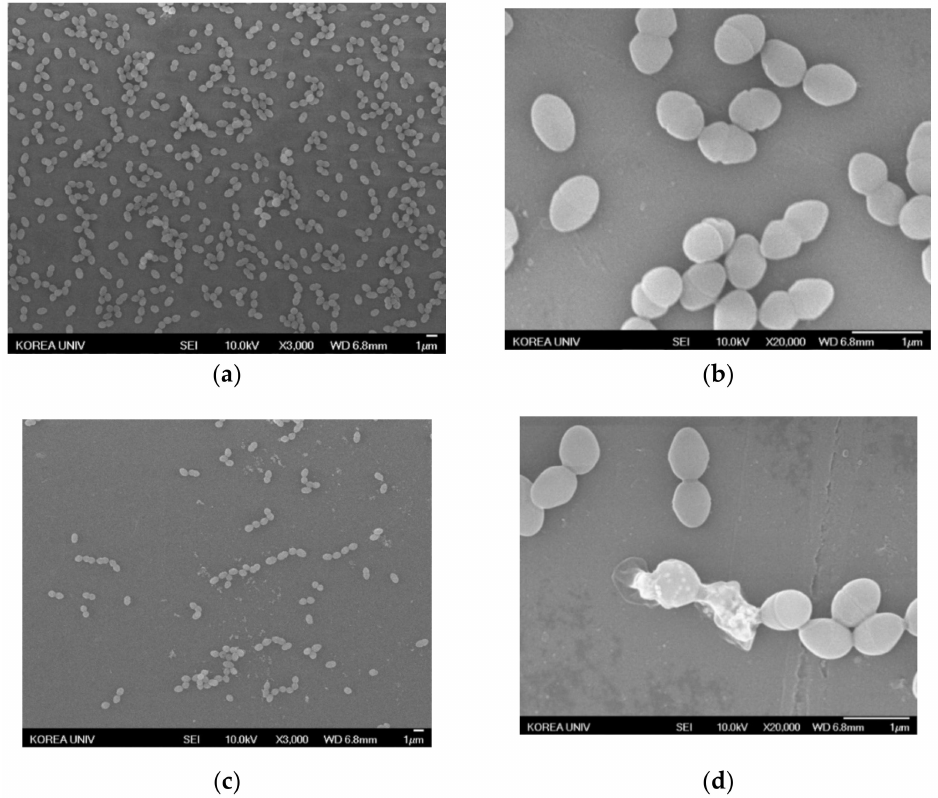
Figure 8. SEM of VRE treated with AgNPs. ( a ) Negative control magnified 3000 × . ( b ) Negative control magnified 20,000 × . ( c ) AgNP-treated VRE magnified 3000 × . ( d ) AgNP-treated VRE magnified 20,000 ×